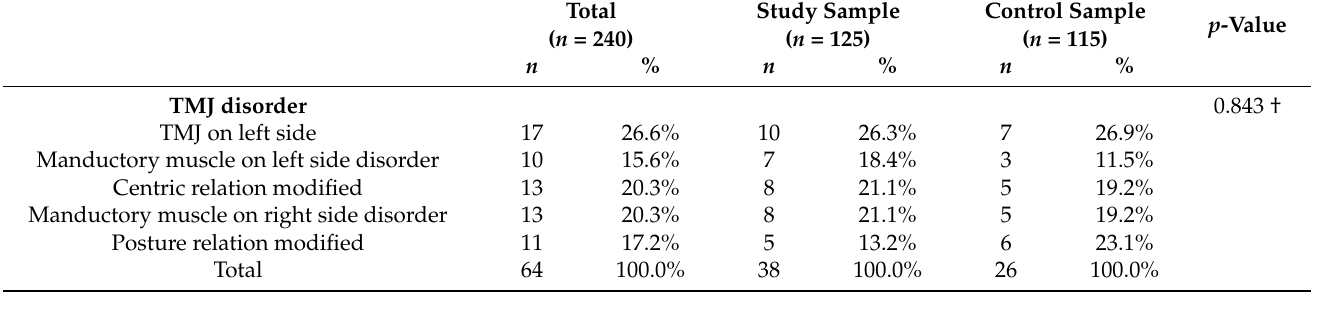
Table 5. TMJ disorders identified in the investigated samples. † Pearson Chi-squared test.